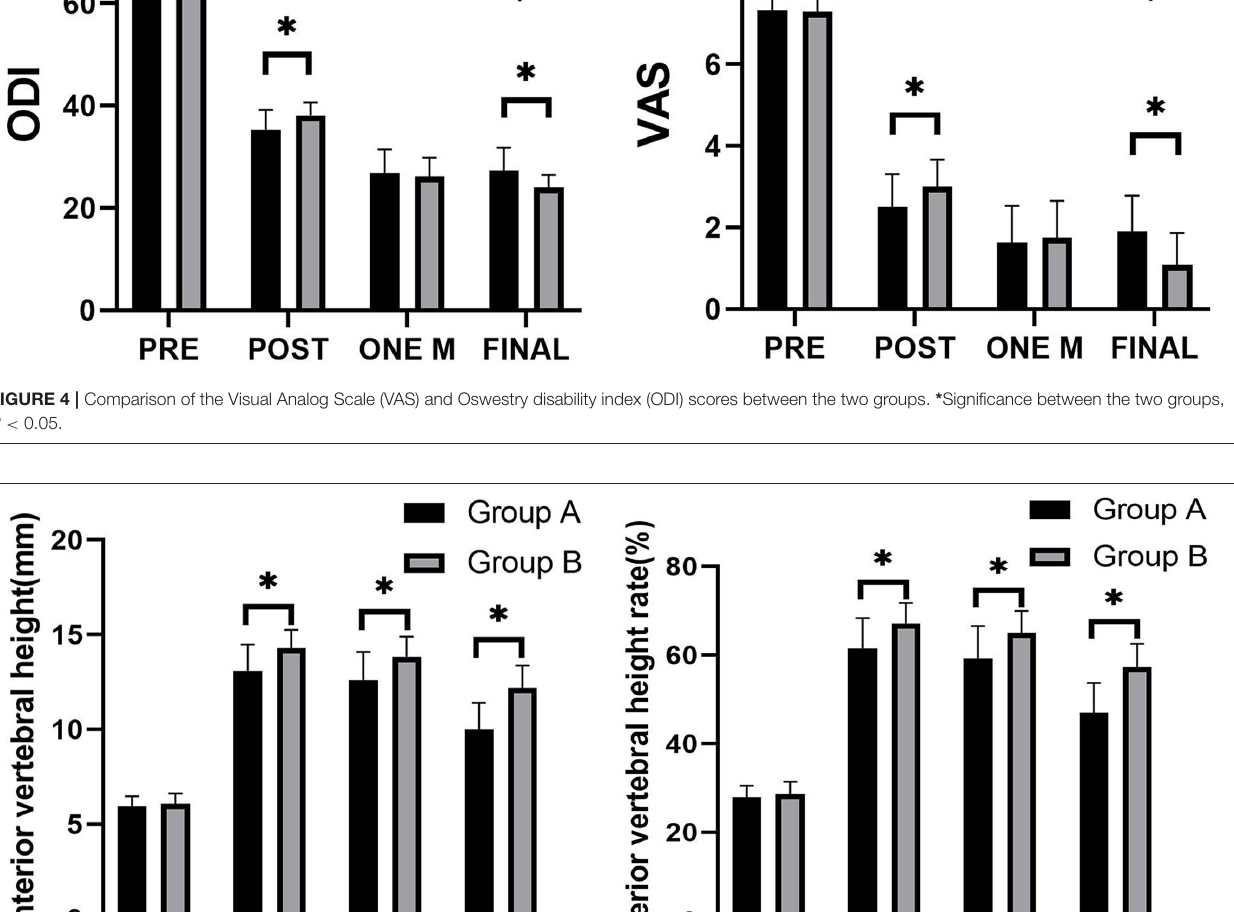
confirmed that PKP is also effective for these patients